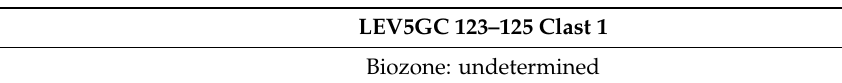
Table A27. Moscow